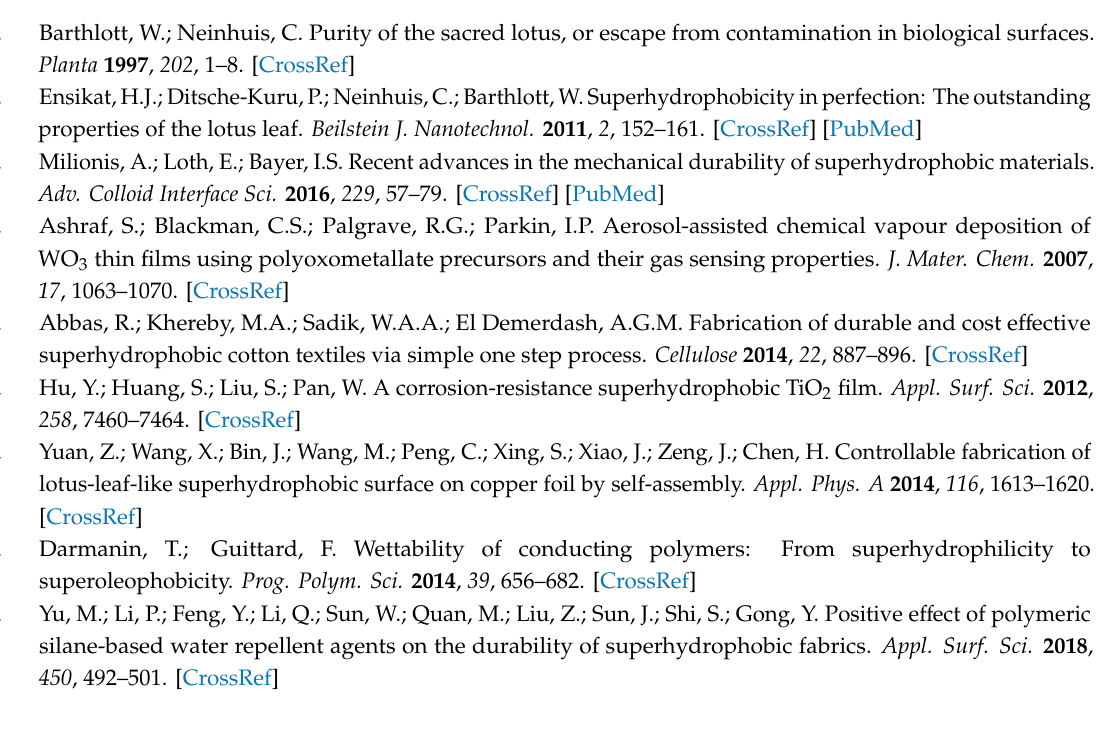
Figure S1: The surface morphology of treated PET fabrics: (a) dipping PEG; (b) PET-g-PEG; (c) PET-g-LMA; (d) PET-g-PEG & LMA, Table S1: Water repellency and washing stability of di ff erent